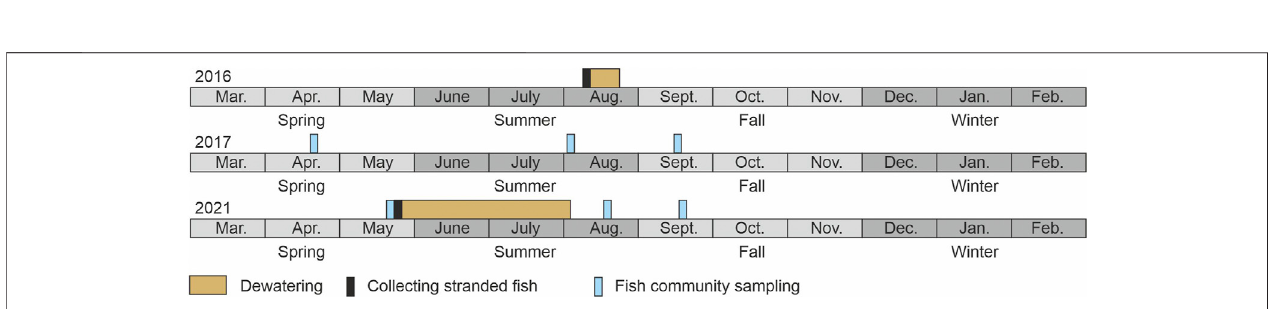
FIGURE2| Timescaleofsamplinganddewateringeventsof2016,2017,and2021separatedbymonthandseason;abbreviationofmonthnamescorrespondsto the common form. Note that the fi sh community sampling in 2021 contains sampling in the restored bank habitats as well as in the main channel of the Hammerbach.